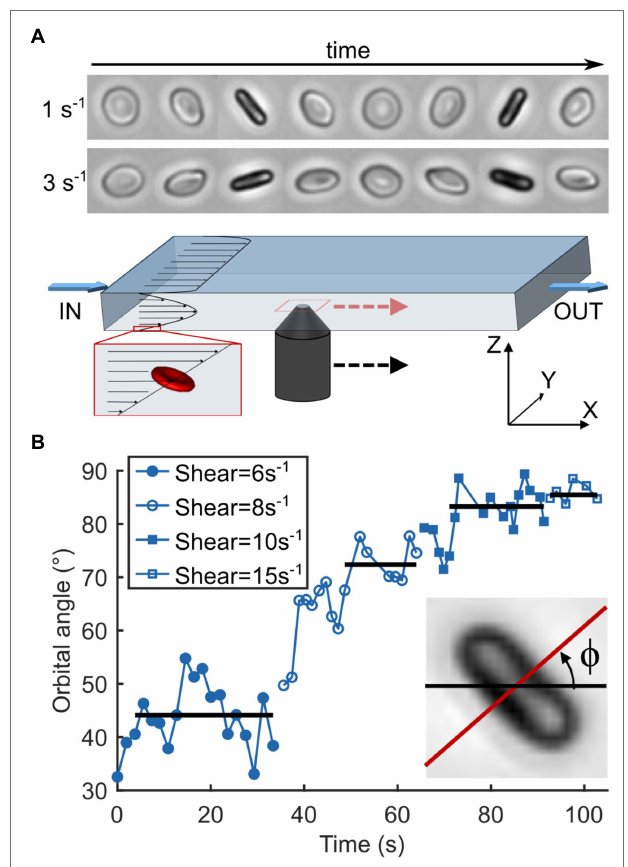
FIGURE 3 | Observation of RBC motion as a function of increasing shear rate. (A) Schematics of the experimental device. A viscous dextran solution containing RBCs is pushed through a parallelepiped chamber (L × W × H: 50 × 10 × 1 mm 3 ). Individual cells of discocyte shape are chosen near the bottom wall ( ≤ 50 μ m) and away from the sides where vertical shear is linear and the horizontal shear is null. They are observed along the flow gradient ( Z -axis) and followed manually while flowing through the chamber by moving the objective. Timelapses on the top show the motion cycles of the same healthy RBC undergoing tumbling at shear rates of 1 and 3 s − 1 with orbital angles of 35 and 75 ° , respectively. (B) Temporal evolution of the orbital angle ϕ of an SCD RBC as a function of a step-by-step increasing shear rate. ϕ is the angle between the orthogonal projection of the cell axis of revolution along the flow gradient ( Z -axis) and the flow direction ( X -axis). Horizontal lines correspond to stabilized ϕ values for each shear rate. Inset: Measurement of ϕ on an RBC image. It is measured each time the cell is on the edge, that is, when the cell axis of symmetry is perpendicular to the direction of